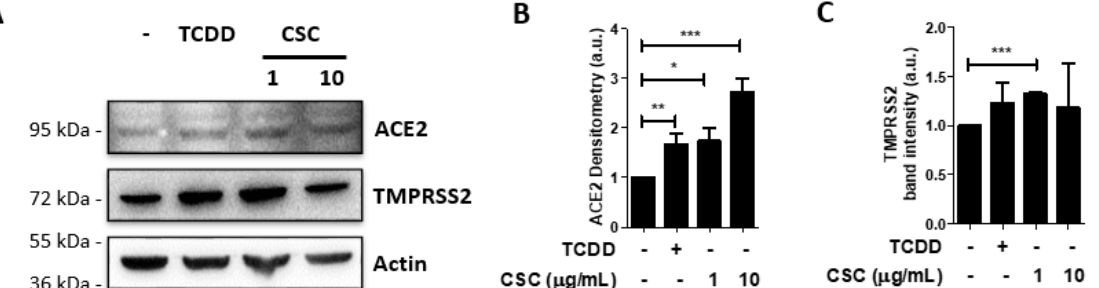
Figure 2. 2,3,7,8-tetrachlorodibenzo-p-dioxin (TCDD) treatment increases angiotensin-converting enzyme 2 (ACE2) levels, but not transmembrane serine protease 2 (TMPRSS2), in human gingival epithelial cells. GECs were treated with or without cigarette smoke condensates (CSC) at different concentrations as indicated, or with TCDD (10 nM), for 24 h. Expression of ACE2 and TMPRSS2 were determined by Western blot. ( A ) shows representative Western blots for ACE2 and TMPRSS2 in GECs after treatment with or without CSC or TCDD. ( B , C ) Graphs show average ± SEM of band intensity (arbitrary units) for ACE2 ( B ) and TMPRSS2 ( C ) . Data shown are representative of at least 3 independent experiments. * p ≤ 0.05; ** p ≤ 0.01; *** p ≤ 0.001.